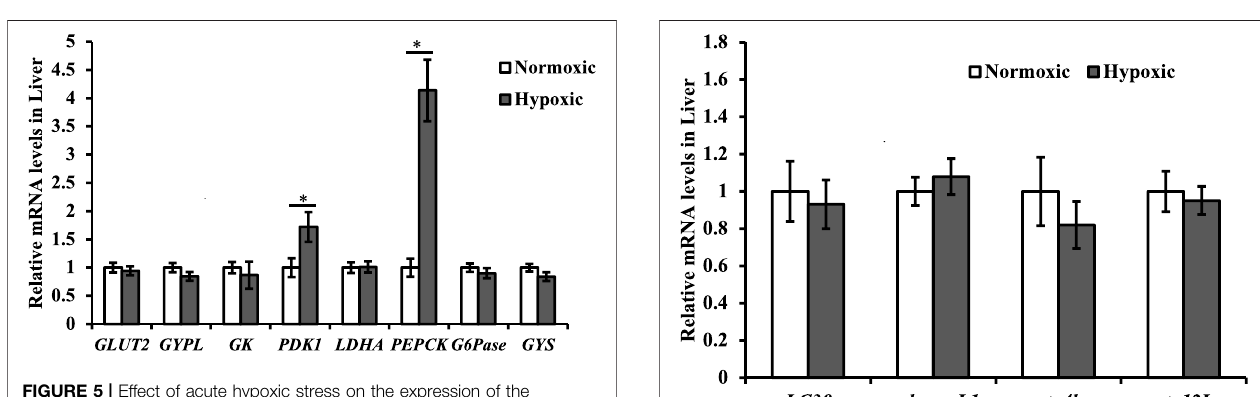
FIGURE 5 | Effect of acute hypoxic stress on the expression of the glycometabolic genes in the liver of triploid rainbow trout ( n = 6; GLUT2, Glucose transporter 2; GYPL, Glycogen phosphorylase liver form-like; GK, Glucokinase; PDK1, Pyruvate dehydrogenase kinase; LDHA, L-lactate dehydrogenase; PEPCK, Phosphoenolpyruvate carboxykinase; G6Pase, Glucose-6-phosphatase; GYS, Glycogen synthase). Asterisks indicate signi fi cant differences ( t -test; * p < 0.05, ** p < 0.01).